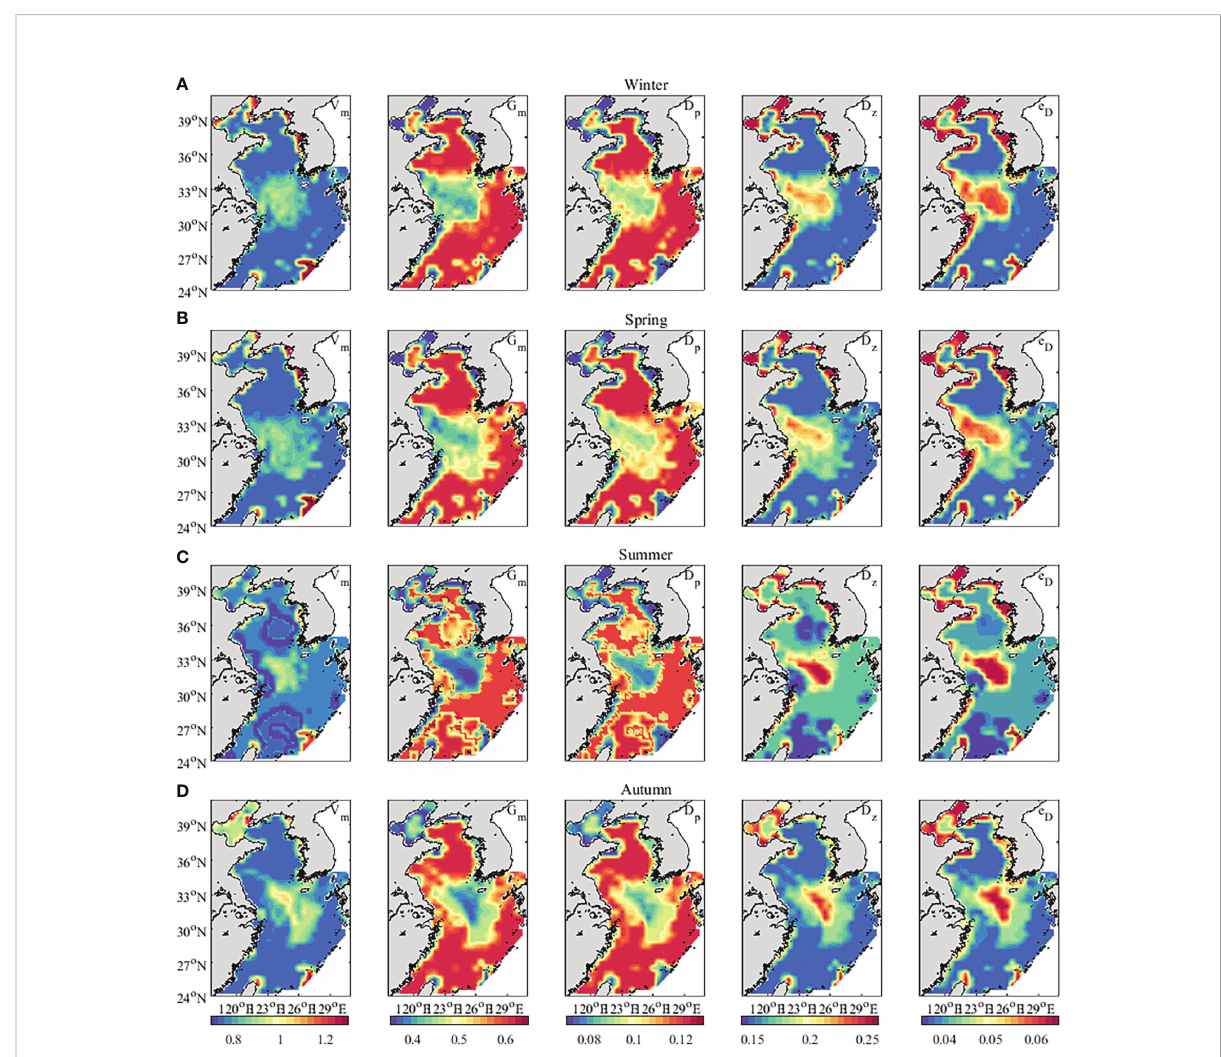
FIGURE 7 The distribution of fi ve parameters inverted by the CFDM (unit: day − 1 ). (A) Winter (Jan-Mar); (B) Spring (Apr-Jun); (C) Summer (Jul-Sep); (D) Autumn (Oct-Dec).